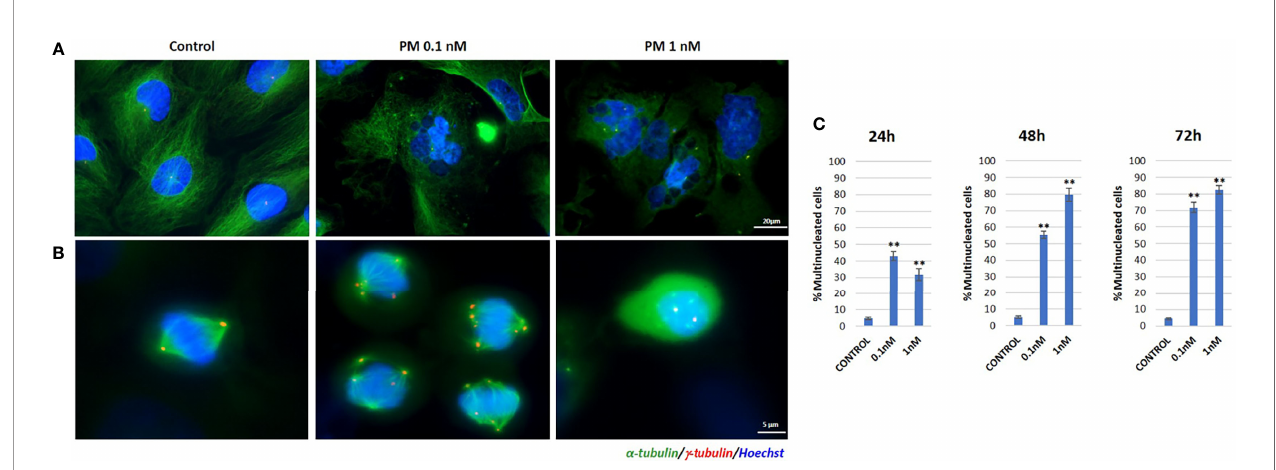
FIGURE 4 | Immuno fl uorescence staining of a - and g -tubulin in plocabulin treated OV866(2) cells. (A) Effects of 48h treatment with plocabulin on microtubule network and appearance of multinucleated cells. (B) Aberrant mitotic spindle polarization and chromosome missegregation after treatment with plocabulin. (C) Bar plots represent percentage of multinucleated cells after treatment with plocabulin (0.1 and 1 nM) at 24, 48 and 72h. PM: PM060184; **: p value < 0.01.